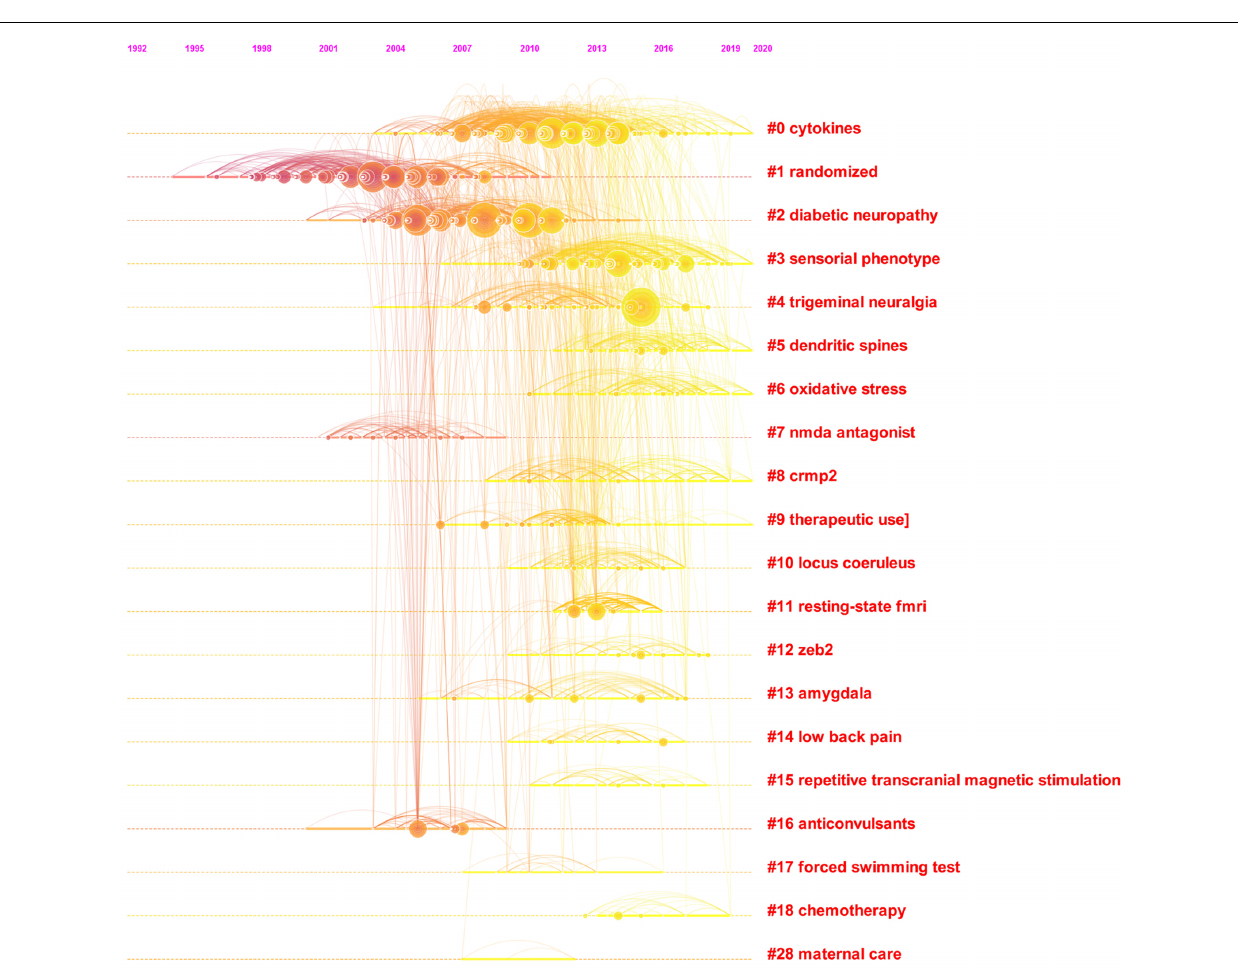
FIGURE 10 | The analysis of references. Co-citation map (timeline view) of references from publications on NP associated with anxiety or depression